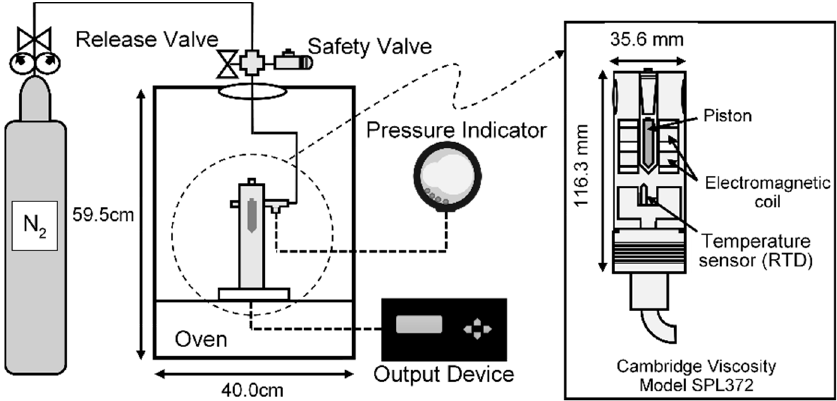
Figure 2. High-pressure high temperature viscometer set-up.